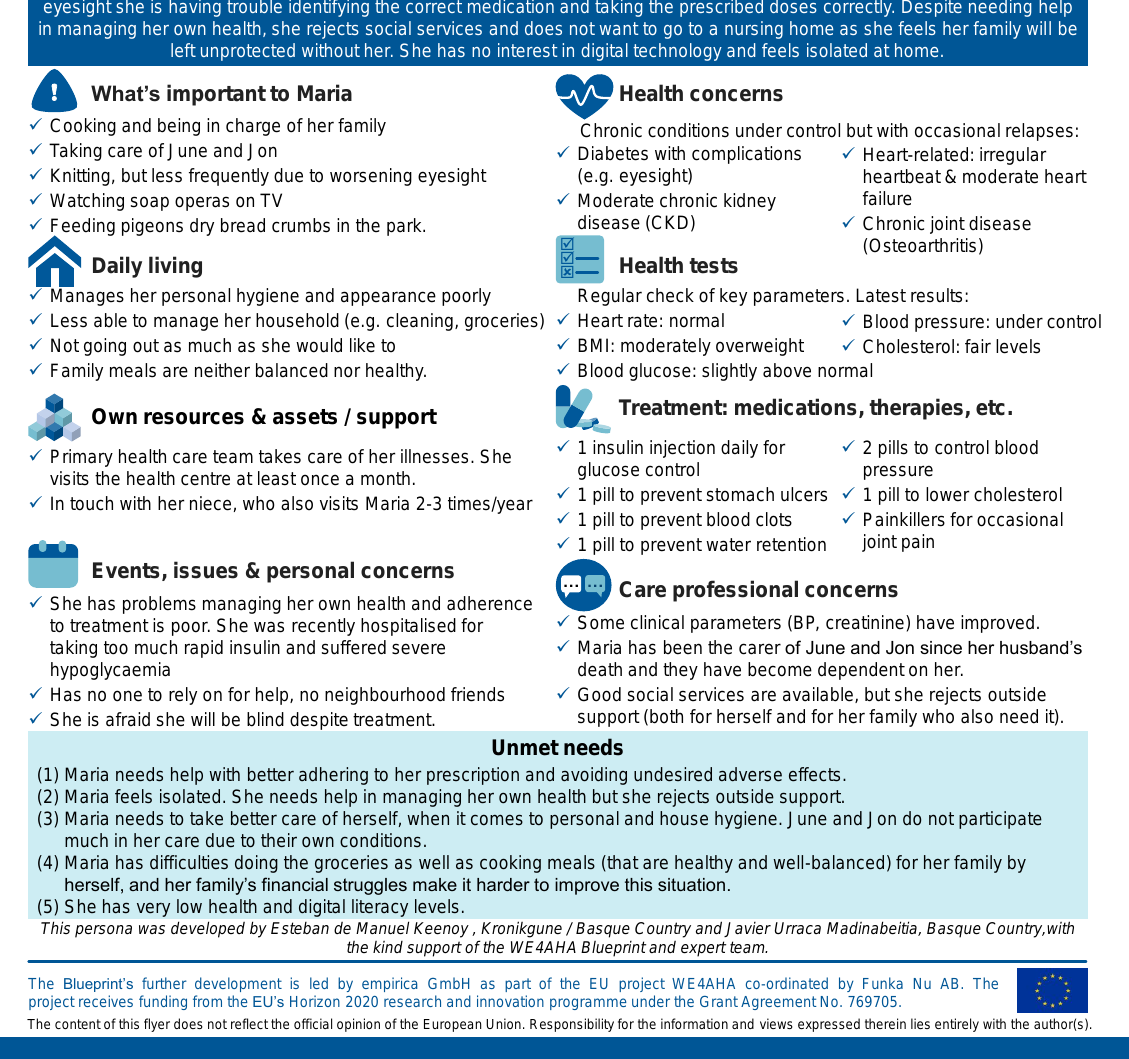
Figure 1. ‘Meet Maria’—Blueprint persona poster. The personas originate from the Blueprint stream of work led by Empirica GmbH as part of the WE4AHA project coordinated by Funka NU AB. The project received funding from the EU’s Horizon 2020 research and innovation